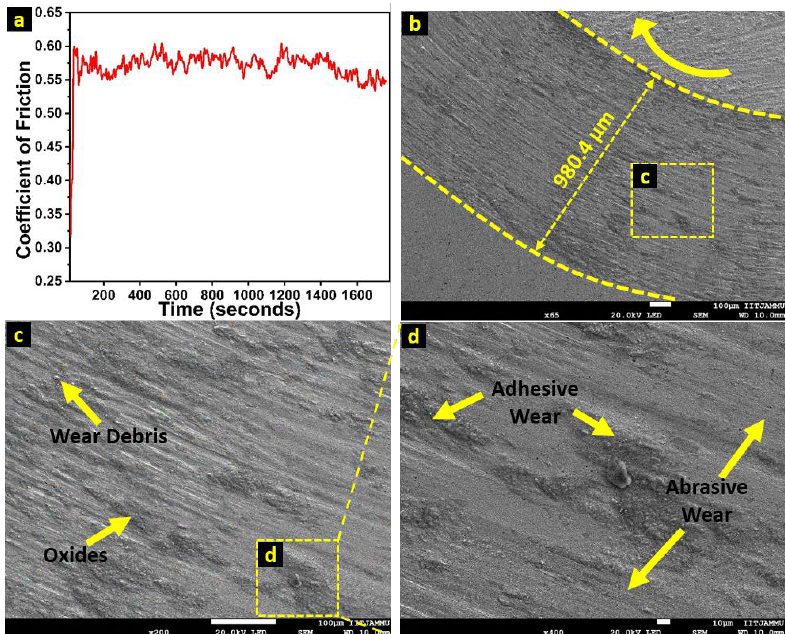
Figure 21. The ( a ) COF plot with respect to time, ( b ) the wear track formed with the aid of counter- body and ( c , d ) magnified image to analyze the type of wear mechanism formed in a sample fabricated using the CMT-based WAAM process.